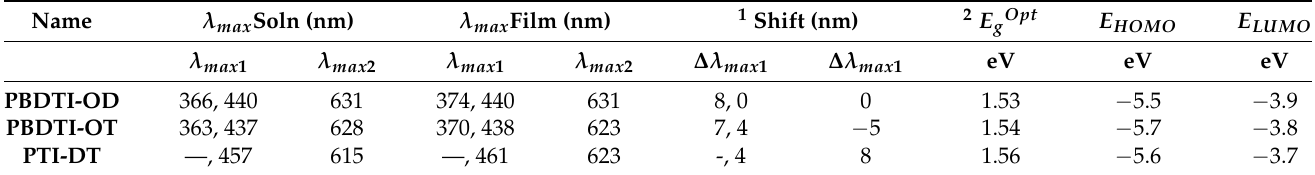
Table 2. Electrochemical and Optical Properties of PBDTI-OT , PBDTI-DT and PTI-DT